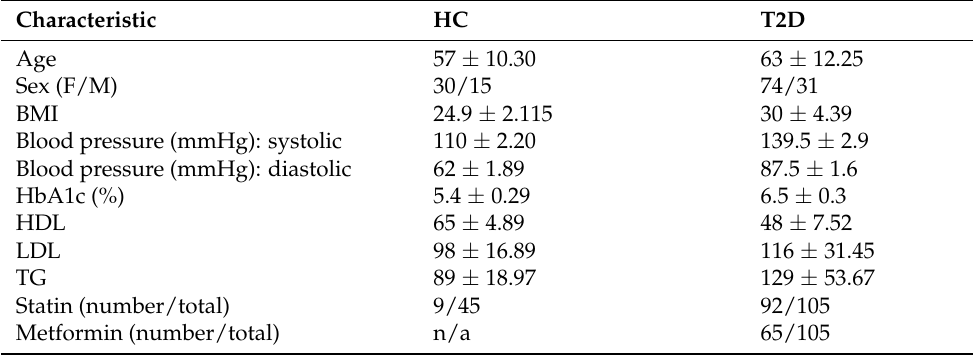
Table 1. Characteristics of Study